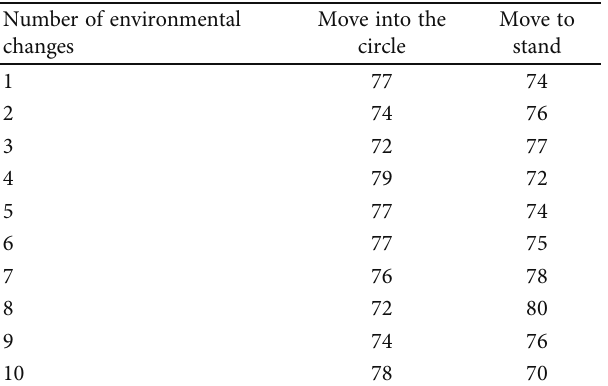
Figure 8: Comparison of diversity within the circle.